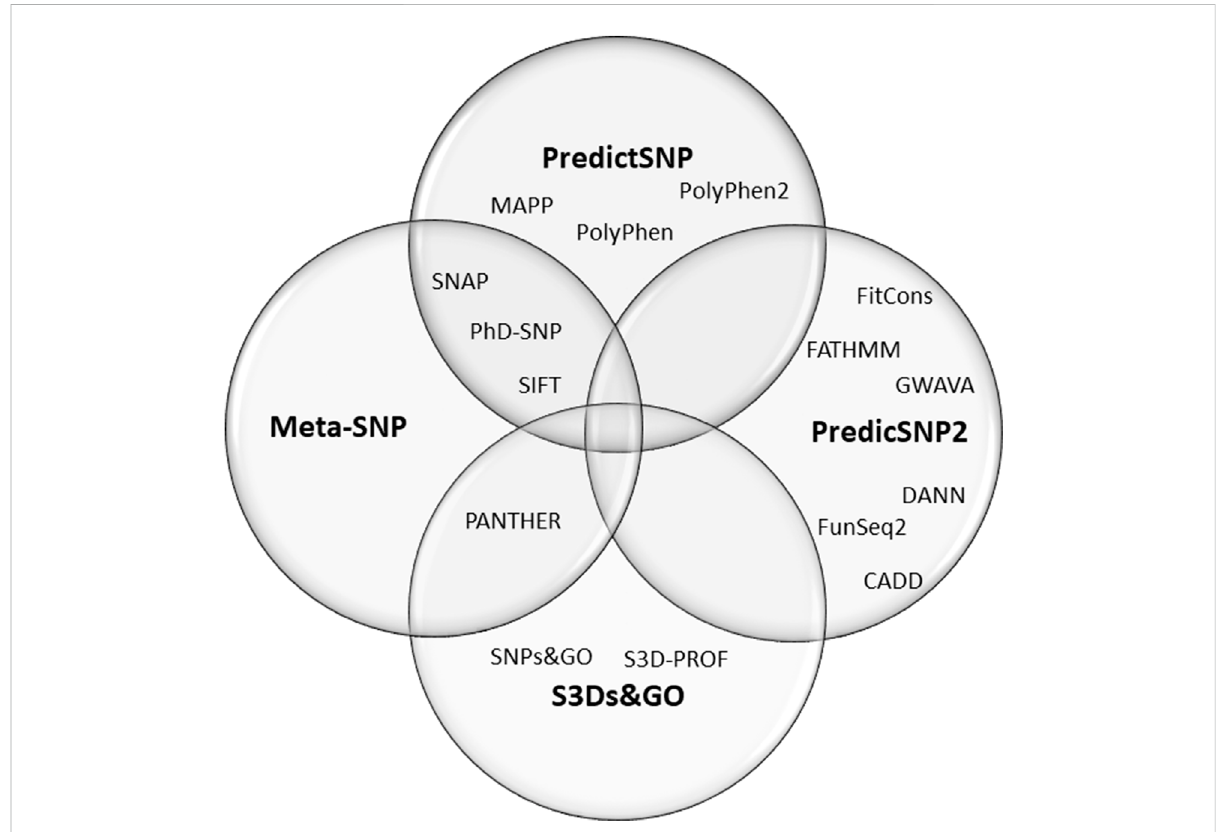
FIGURE 1 Compositionofthefourmeta-predictorsstudied.ThePredictSNPalgorithmcomprisestheoutputsofsixsingle-predictors,thePredictSNP2of six, the Meta-SNP of 4, and the S3Ds&GO of three